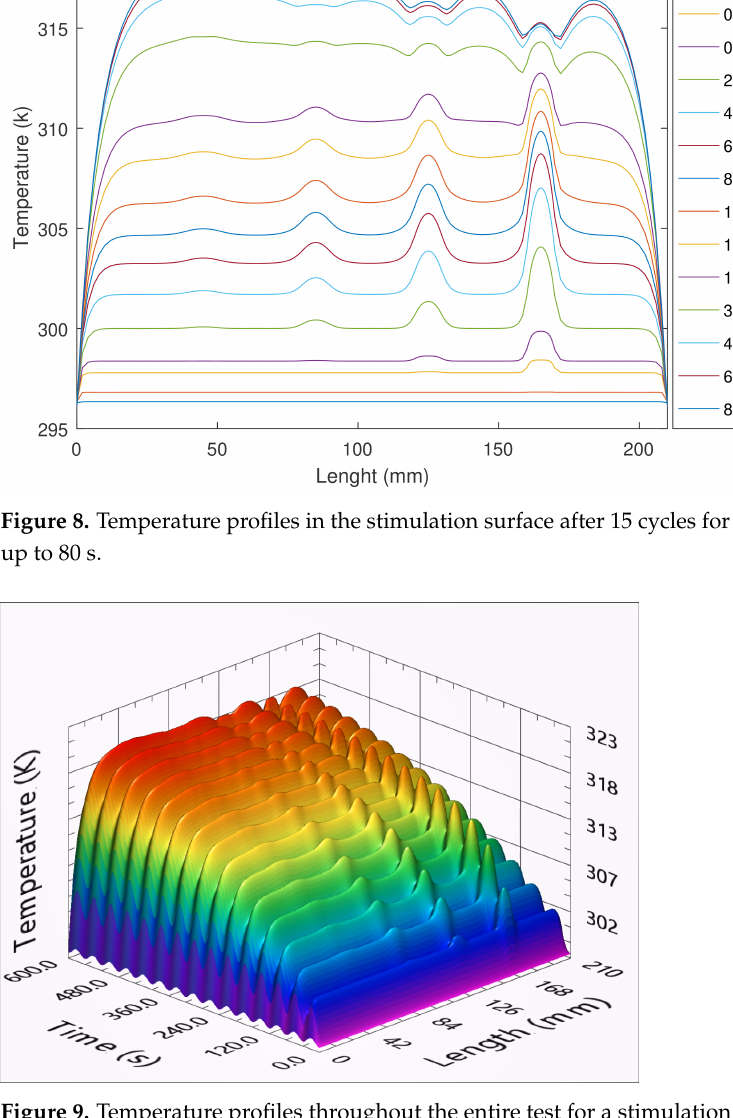
Figure 9. Temperature profiles throughout the entire test for a stimulation period of 40